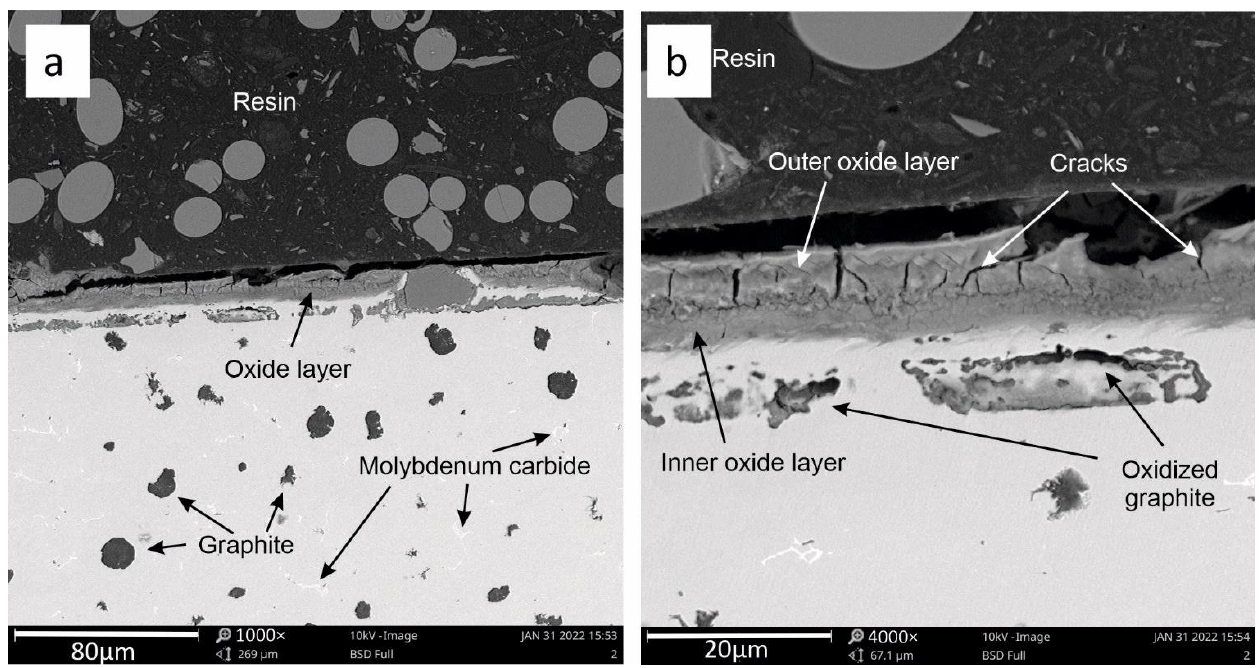
Figure 9. View of the oxide layer after three heating cycles ( a ) for sample 1. Detailed description of the oxide layer ( b ).